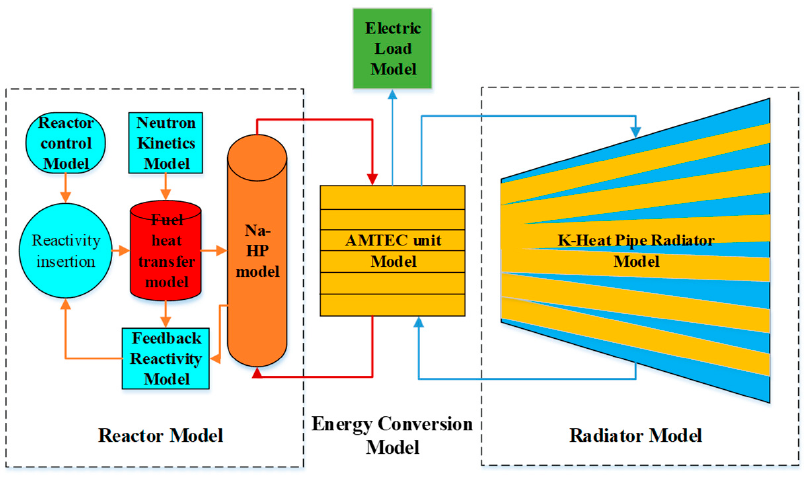
Figure 2. Schematic of the TAPIRS code.